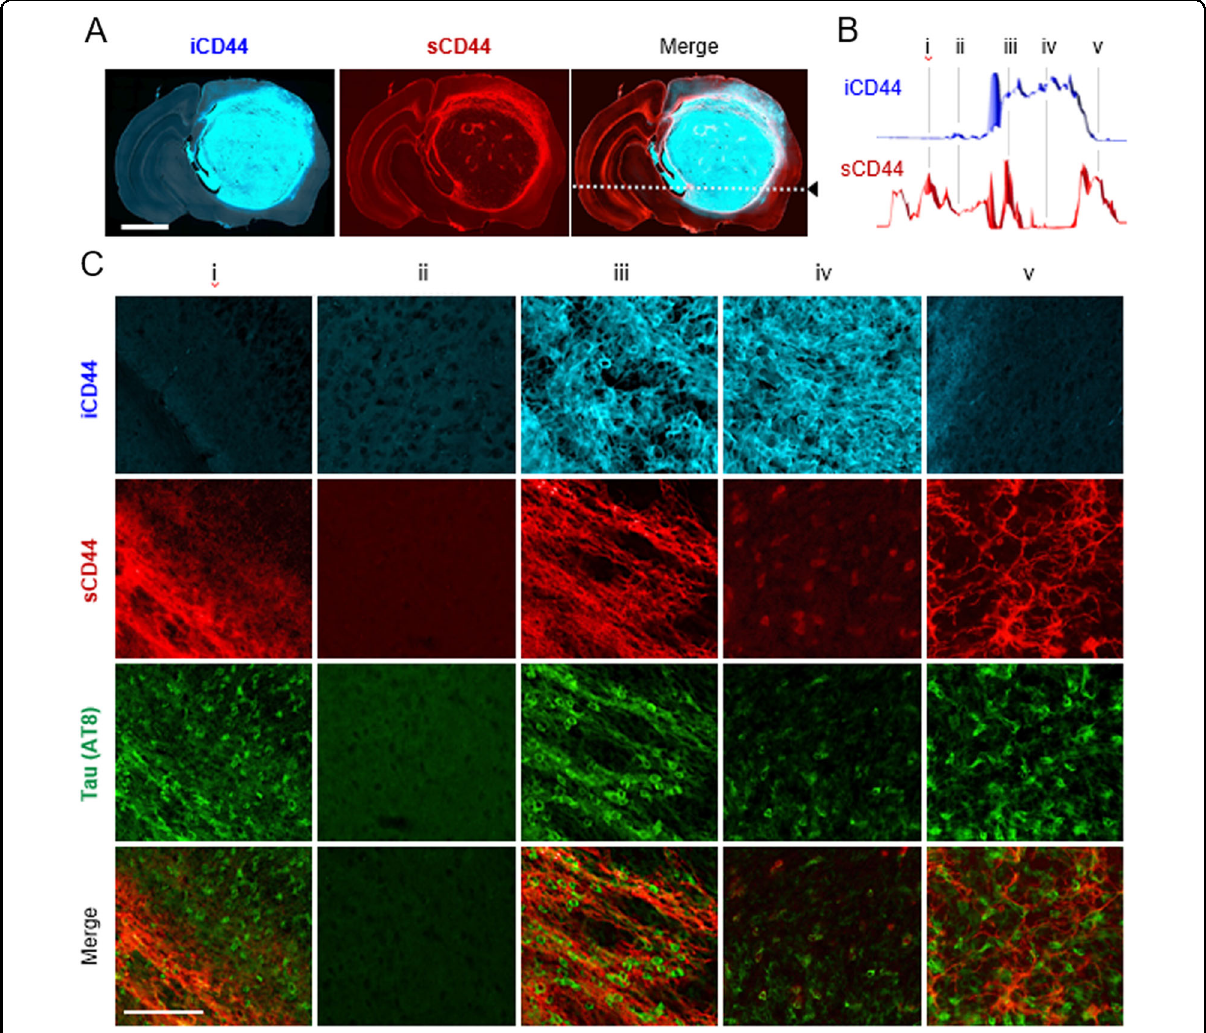
Fig. 5 Tau pathology correlates with sCD44 distribution. a Distribution of intracellular CD44 (iCD44) and soluble CD44 (sCD44) in the U87- xenograft brain tissue. Scale bar, 2 mm. b Fluorescence intensity pro fi les of iCD44 and sCD44 along the dashed line of the tissue section in a . Based on the intensity pro fi les, fi ve regions (labeled from i to v) were selected. c CD44 and tau immuno fl uorescence images of the fi ve selected regions. U87-xenograft brain tissue was immuno fl uorescence stained with anti-iCD44, anti-sCD44, and anti-AT8 antibodies. Scale bar, 100